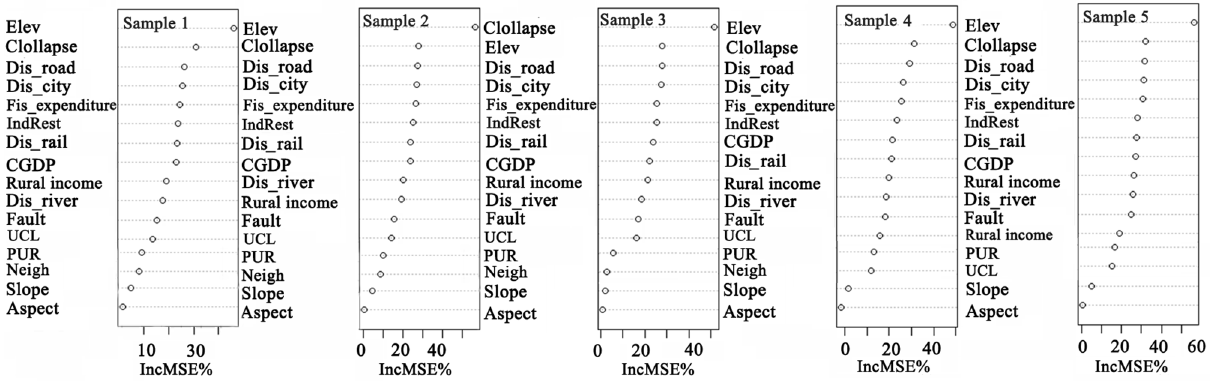
Figure 5. Importance ranking of driving factors by RF model.